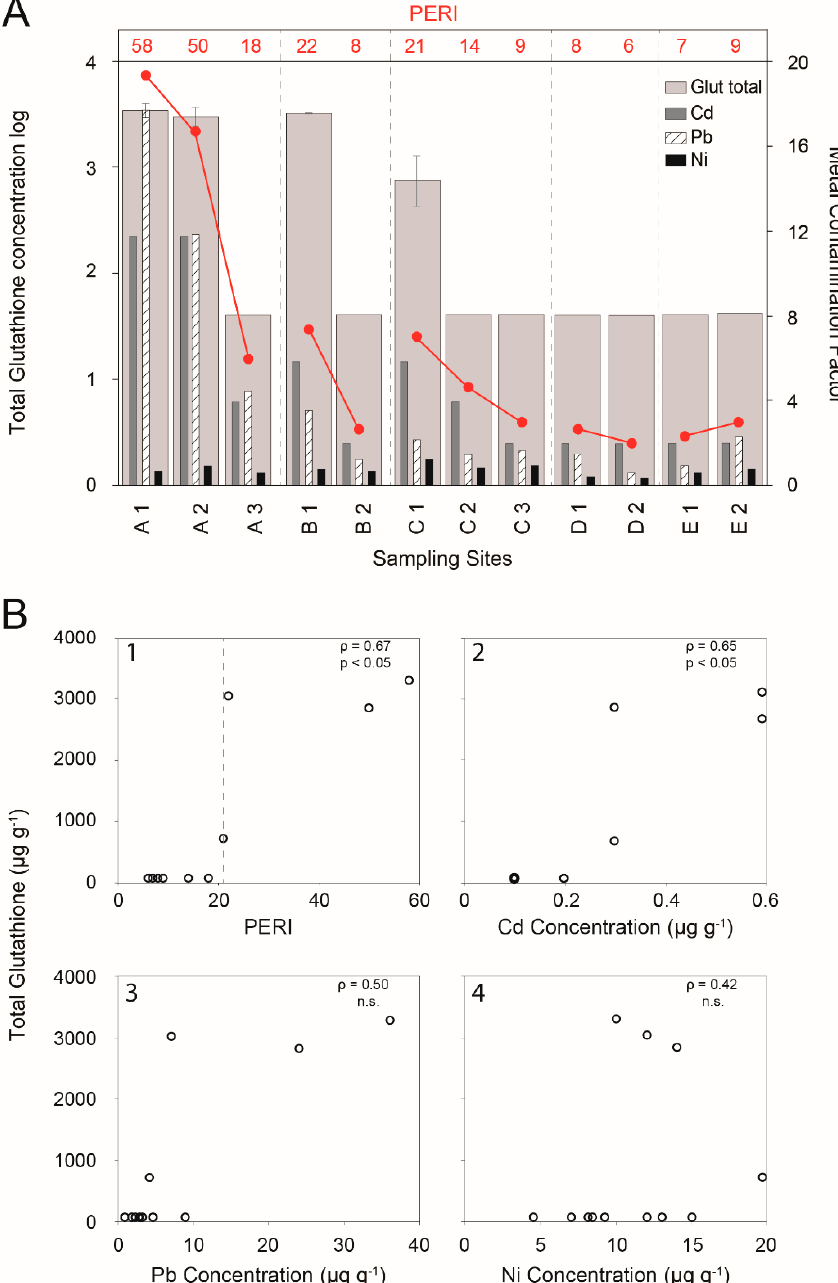
Figure 1. ( A ) Logarithm of the total glutathione concentration (µg g − 1 f.w.; vertical lines show the standard deviation), Metal Contamination Factor for Cd, Pb, and Ni and the PERI (line and values in red) in the moss tissues in each sampling site (A and B = ferrous smelter, C = aluminium smelter, D = ceramics factory, E = chipboard manufacturing plant). ( B ) Spearman correlations ( р ) between the total glutathione concentration (µg g − 1 f.w.) and PERI ( 1 ), Cd concentration (µg g − 1 d.w.) ( 2 ), Pb concentration (µg g − 1 d.w.) ( 3 ), and Ni concentration (µg g − 1 d.w.) ( 4 ) in mosses. n.s. = not significant.